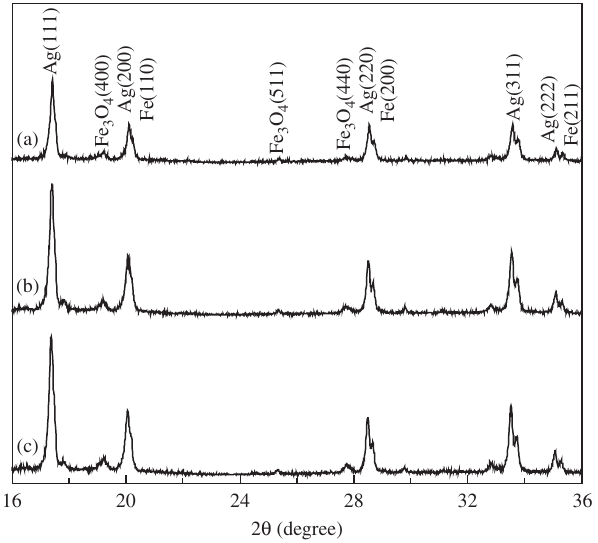
Figure 1. X-ray powder patterns of Fe Sintered at 300 °C; and c) Sintered at 300 °C and annealed at T